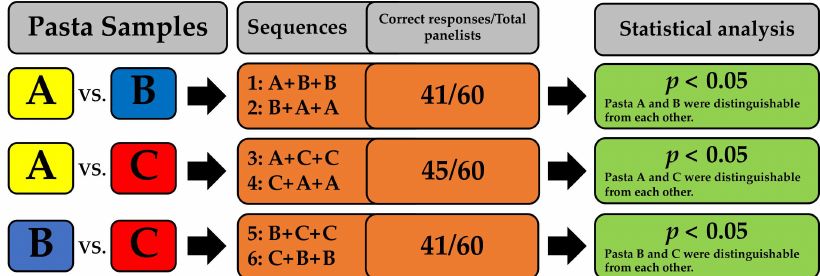
Figure 3. Triangle test to evaluate the capability of the panelists to discriminate among pasta samples. Sixty untrained panelists were recruited. Pastas (A, B, C) were assigned a code and presented simultaneously to all panelists. In each sample sequence, two equal pastas and one di ff erent pasta were given to panelists. Statistical di ff erences were estimated according to